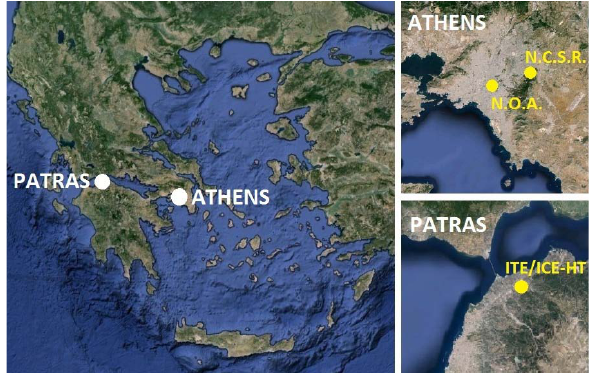
Figure 1. Maps of Greece, Athens, and Patras together with the locations of the measurement sites used during the three